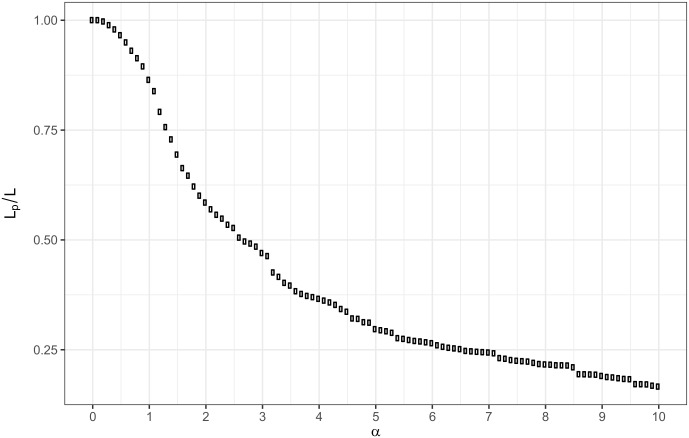
Distribution of the education—occupation significance values as the ratio of the remaining edges after pruning with different α.